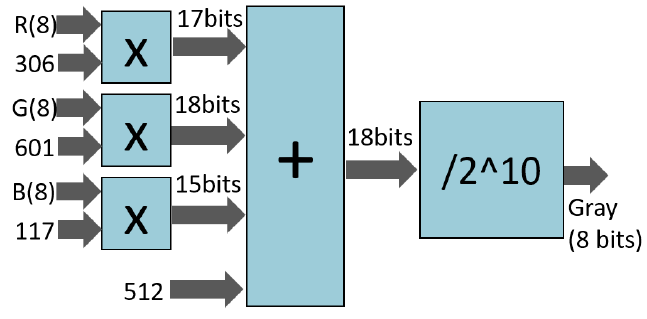
Figure 15. Convert to gray block diagram.